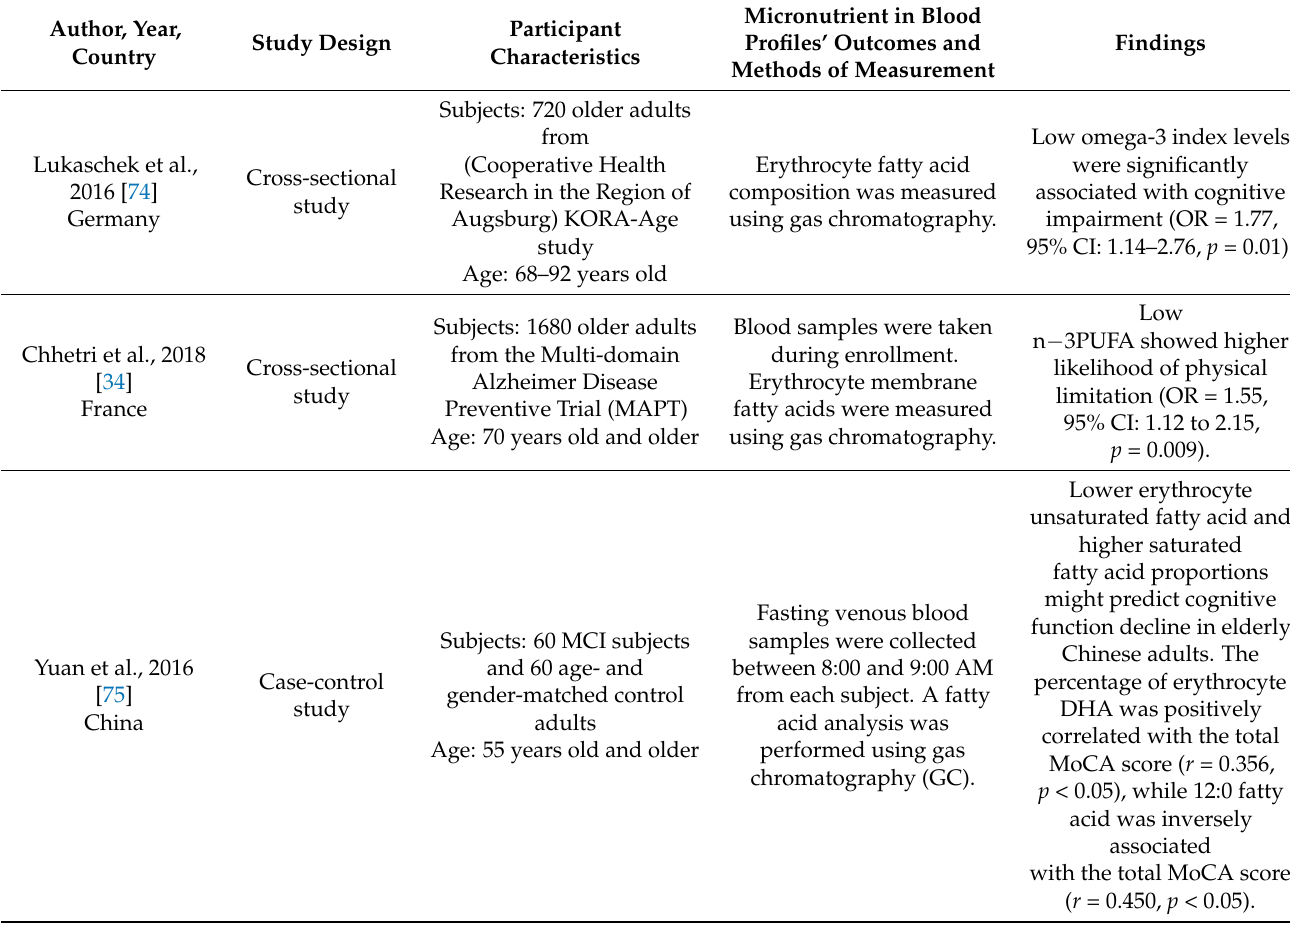
Table 7. Summary of studies evaluating the association between lipids with mild cognitive impair- ment, frailty, and cognitive frailty involved in the